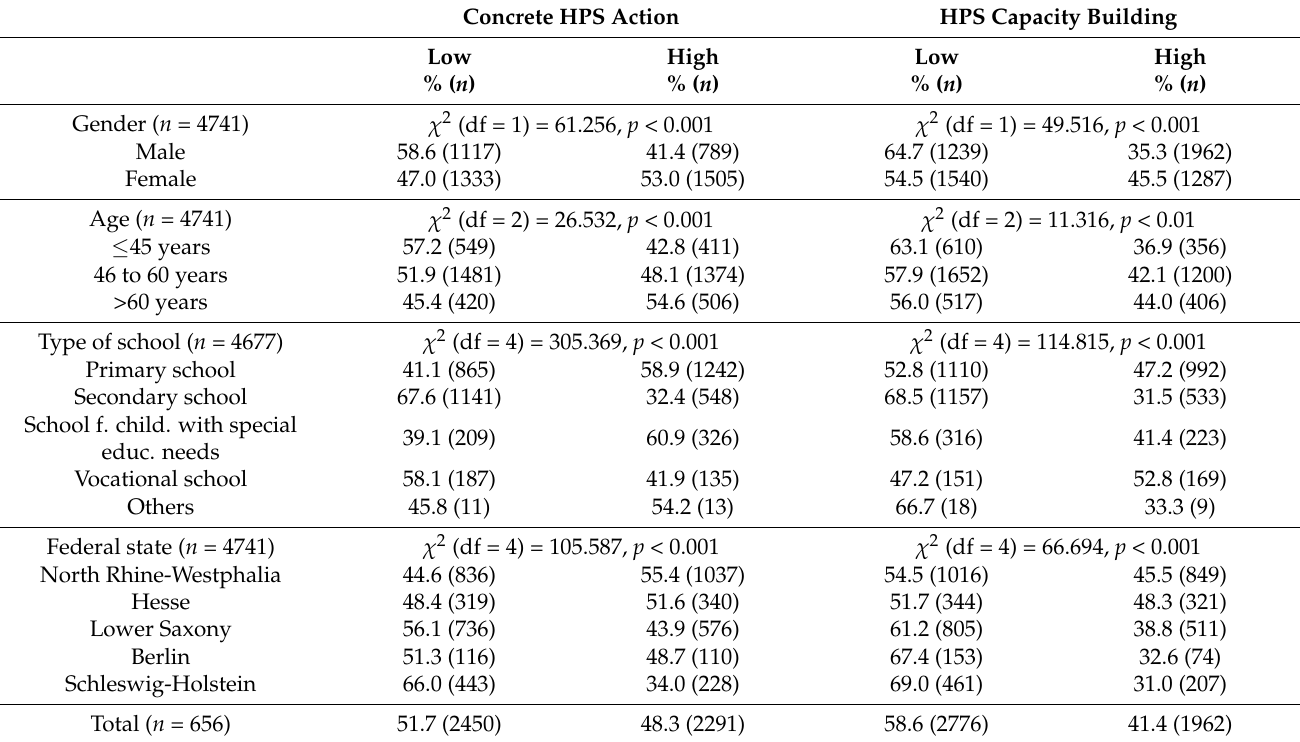
Table 4. HPS implementation stratified by sociodemographic and work